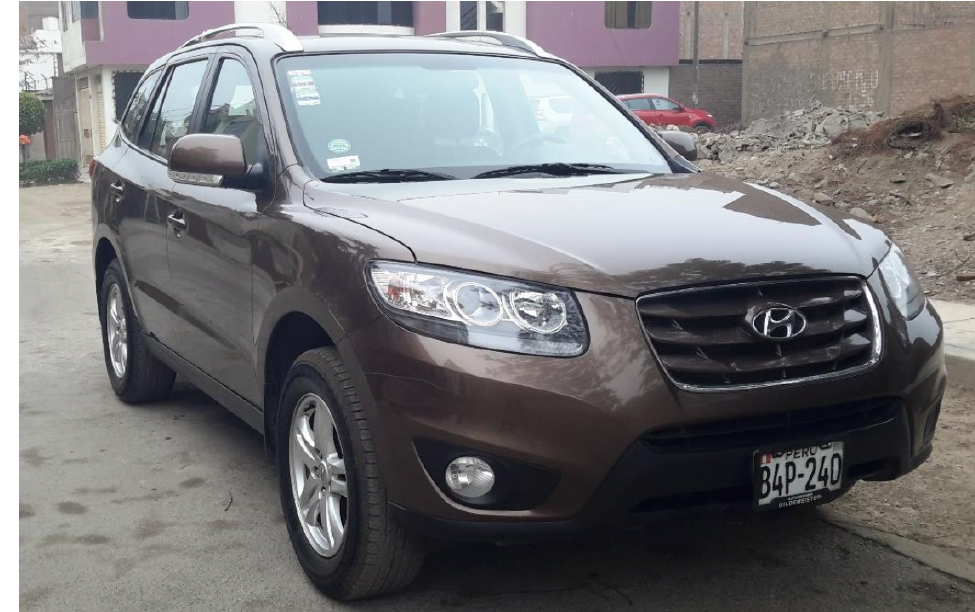
Figure 3. 2010 Hyundai Santa Fe.